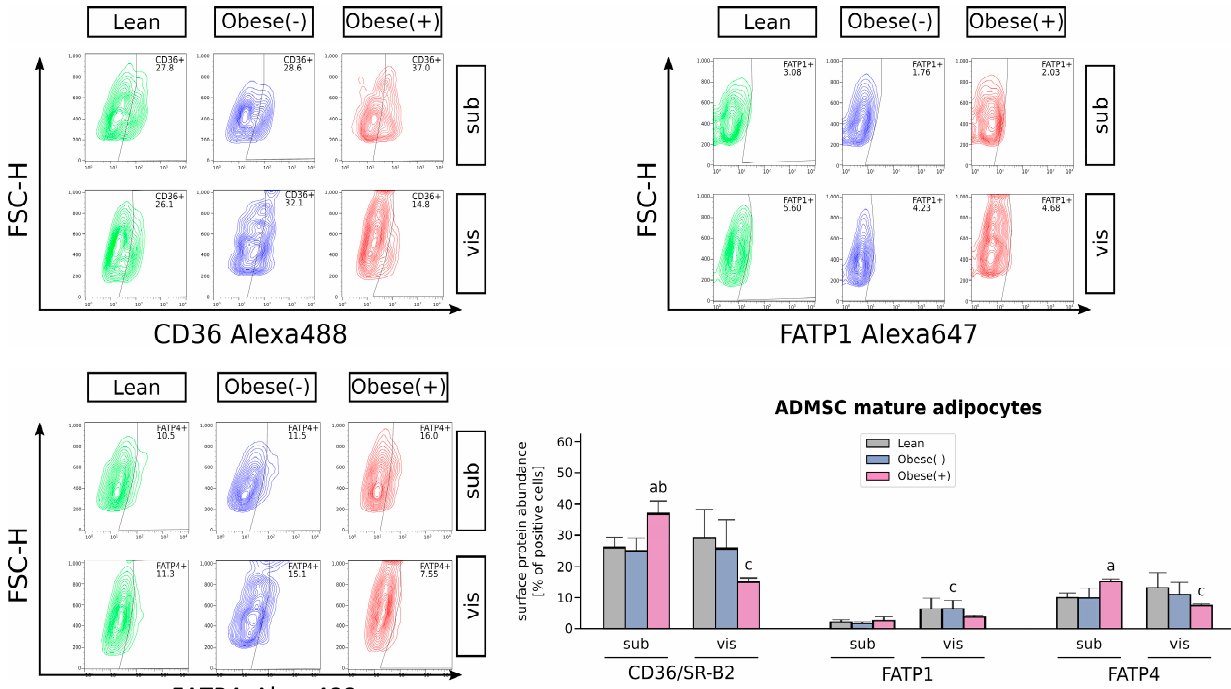
Figure 4. Flow cytometric analysis of cell surface expression of FA transporters in adipocytes derived from subADMSCs and visADMSCs of lean and morbidly obese women. The quantification of the cell populations staining positively for CD36/SR-B2, FATP1 and FATP4. Representative plots are shown. a–difference vs. Lean group in the studied tissue; b–difference vs. Obese(-) group in the studied tissue; c–difference between adipocytes differentiated from visADMSCs vs. subADMSCs within the patient metabolic status. Data are presented as mean ± SD ( n = 3 for each study group, measurements taken in duplicate). p < 0.05. Designation of the groups: Obese(-)–obese without metabolic